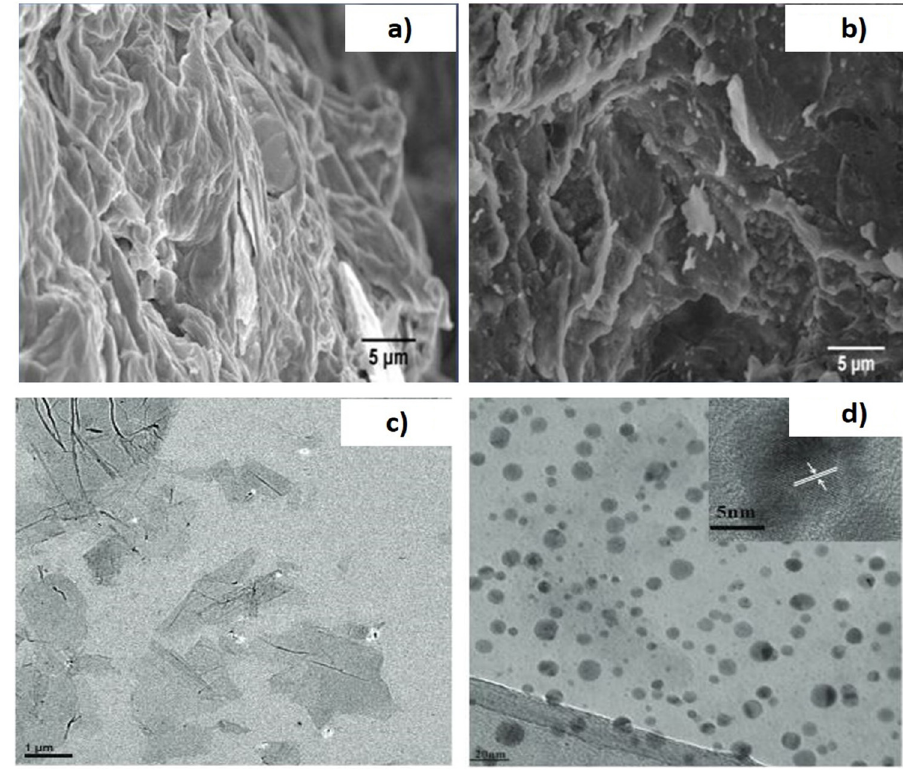
Figure 3: ( a and b ) FESEM images and ( c and d ) HRTEM image of GO and rGO – Au. Adapted from ref. [ 36 ]